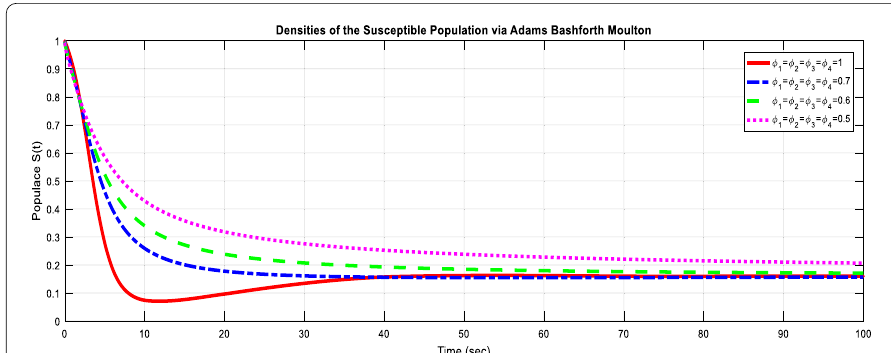
Figure 30 Dynamic of populace S ( t ) by varying the value of φ